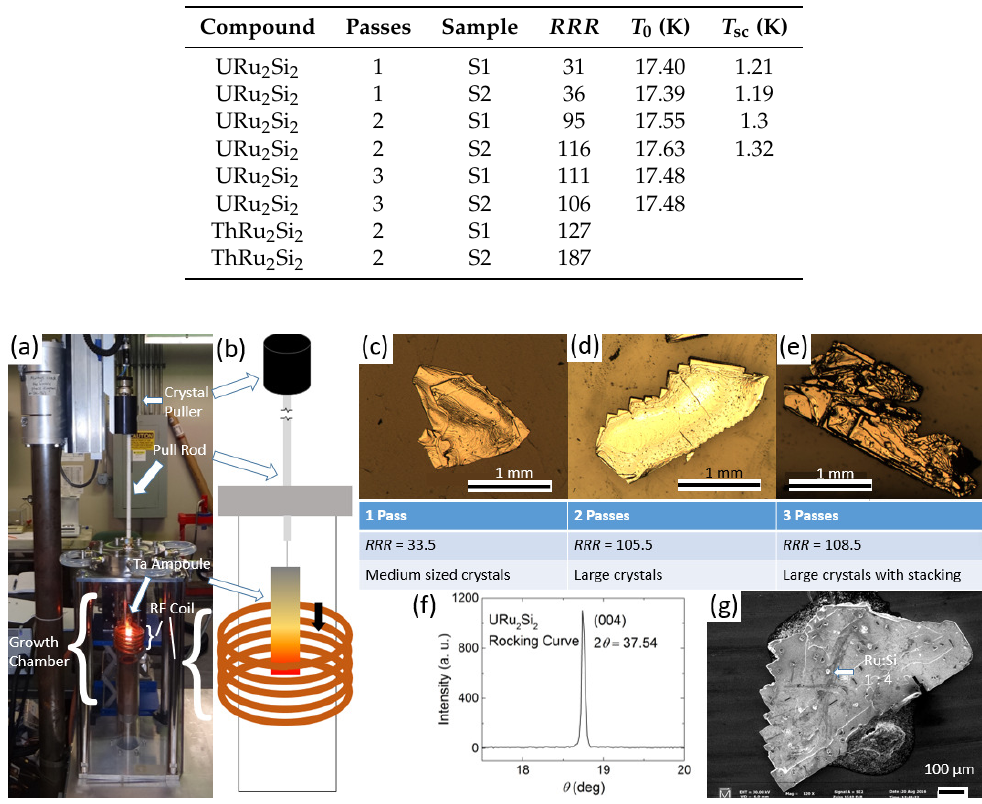
Figure 1. ( a ) Bridgman crystal growth apparatus showing the inert gas growth chamber, rf-heating coil, tantalum ampoule, pull rod, and crystal puller; ( b ) Schematic of the Bridgman crystal growth apparatus; ( c – e ) Images of representative crystals of URu 2 Si 2 that were produced using different numbers of passes through the hot zone; ( f ) Rocking curve for a single crystal of URu 2 Si 2 , showing that the direction perpendicular to the crystalline plate is the c -axis; ( g ) SEM image of a typical URu 2 Si 2 specimen. The surface impurity phase is